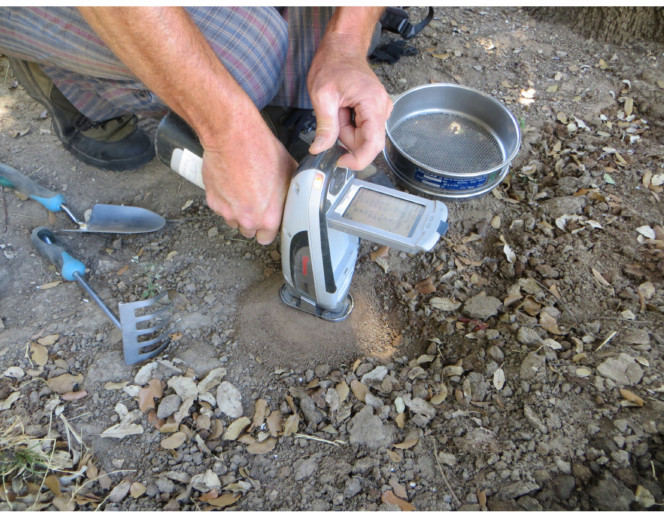
Figure 2. A modern tube-type pXRF spectrometer in on-site operation for a soil survey. The sample preparation procedure used here comprises a dry sieving to 2 mm, manual homogenisation of the sieved fraction, and light compaction by the shovel back. Sampling depth depends on the local soil profile and of the purposes of the study. Gravel and vegetal debris are removed by hand before